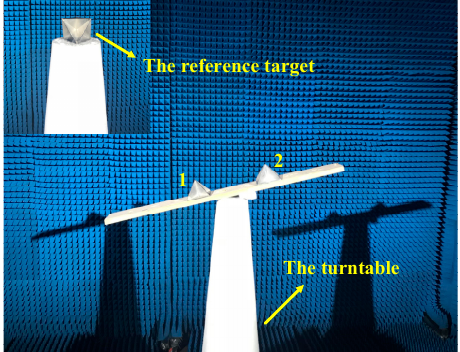
Figure 4. Imaging scene of two corner reflectors.